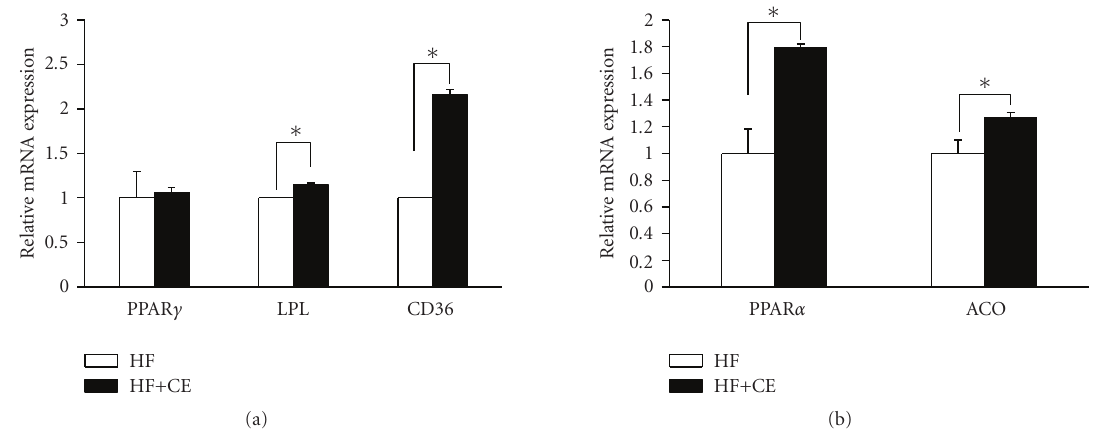
Figure 5: CE promoted gene expression of PPAR γ , PPAR α and their target genes in WAT and liver from DIO mice: (a) real-time PCR of PPAR γ and its target gene expression in white fat tissue; (b) real-time PCR of PPAR α and its target gene expression in liver. HF: high-fat diet; n = 5; data are presented as mean ± SE. ∗ P < . 05 compared to